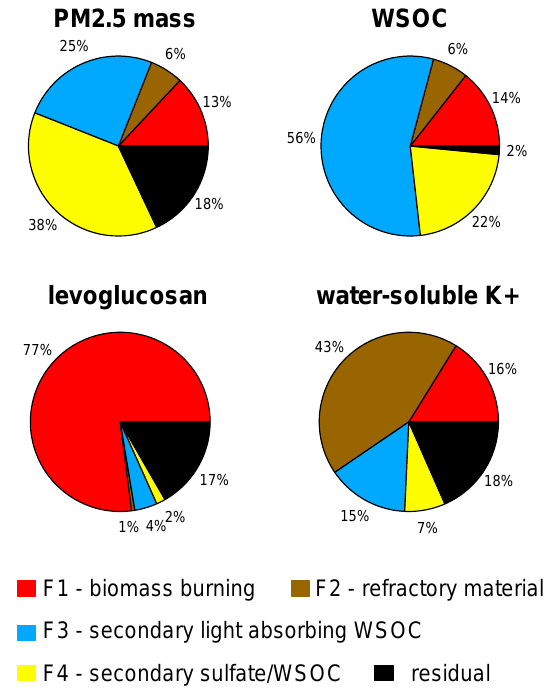
Fig. 10. PMF results showing annually averaged source contribu- tions to PM 2 . 5 mass, WSOC, levoglucosan, and water-soluble K + .